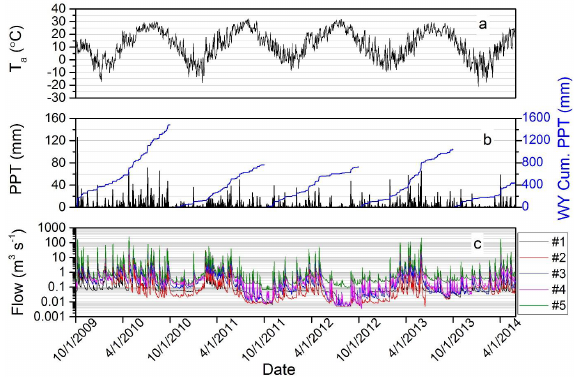
Figure 2. Five-site-average air temperature (Ta; °C) (panel a), five-site-average daily precipitation (PPT; mm), cumulative water year precipitation (WY Cum. PPT; mm) (panel b), and average daily streamflow (m 3 s − 1 ) (panel c) at each gauging site ( n = 5) during study period (October 2010–May 2014) in Hinkson Creek Watershed, MO,